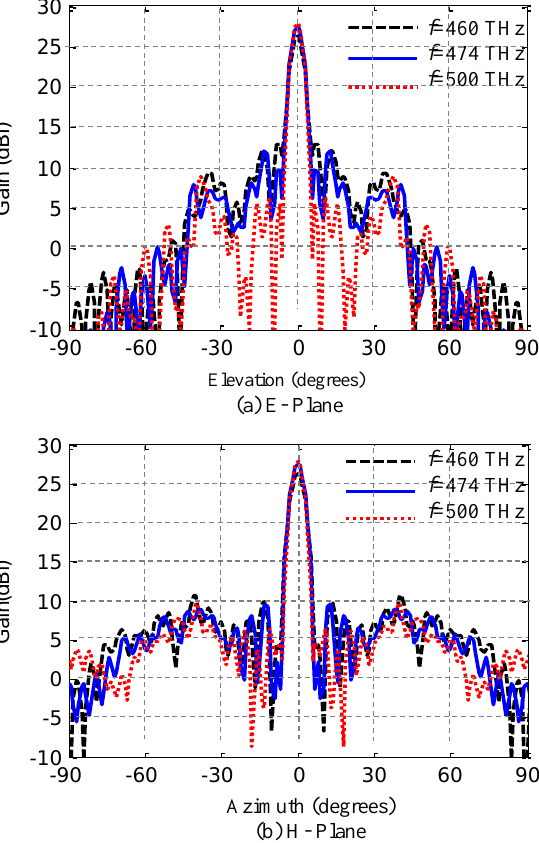
Figure 16 The gain patterns for 21×21 NDRA transmitarray with silver supporting plane at 474 THz. h =50 nm, L =350 nm, and h d =50 nm.